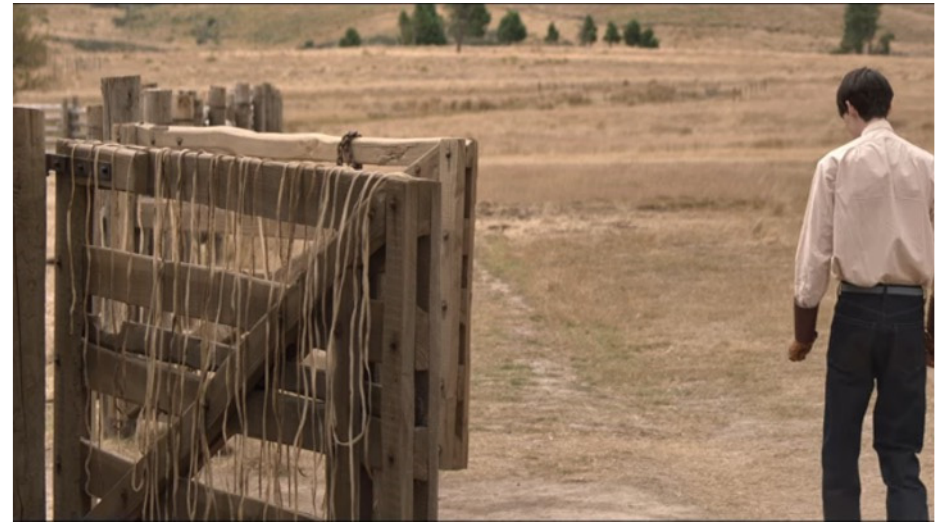
Figure 17. The Power of the Dog . Netflix.